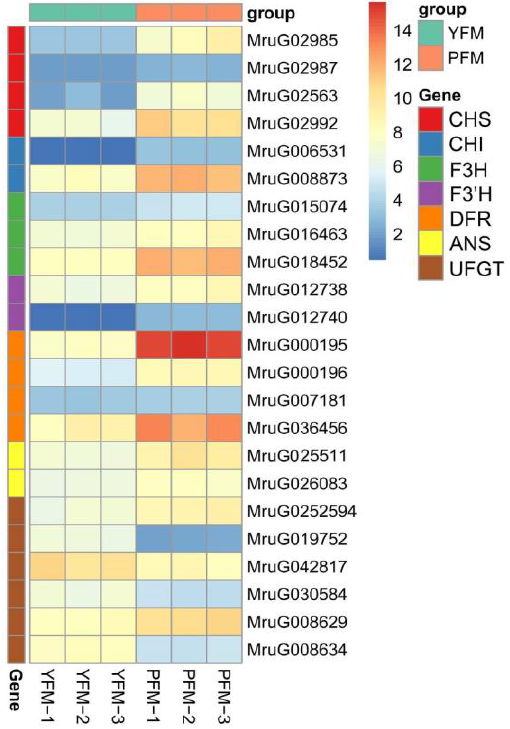
Figure 8. Expression profiles of 23 candidate genes and qRT-PCR validation with the heatmap. Heatmaps of differentially expressed genes’ (DEGs) validation in PFM − 1 vs. YFM-1, PFM − 2 vs. YFM − 2, and PFM − 3 vs. YFM − 3. In this study, PFMs served as the control group, and EF-1 α was used as the internal reference gene for normalization. Gene expression was calculated using the 2 −ΔΔCT method. The color grids on the left with red, blue, green, orange, yellow, and brown represent CHS , CHI , F3H , F3′H , DFR , ANS , and UFGT , respectively. The top grids represent samples of PFM (green) and YFM (orange), PFM−1–3 and YFM−1–3 represent the three biological independent PFM and YFM samples, respectively. The gene names and related gene IDs are listed on the right. The different colors, from blue (low) to red (high), show the expression of the 23 DEGs.